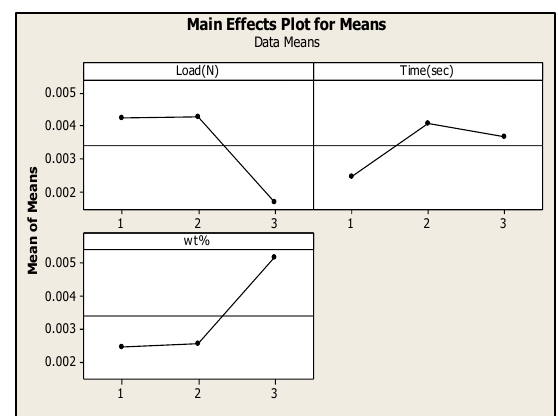
Figure 14: Main effect plots for means - Wear rate at low speed.